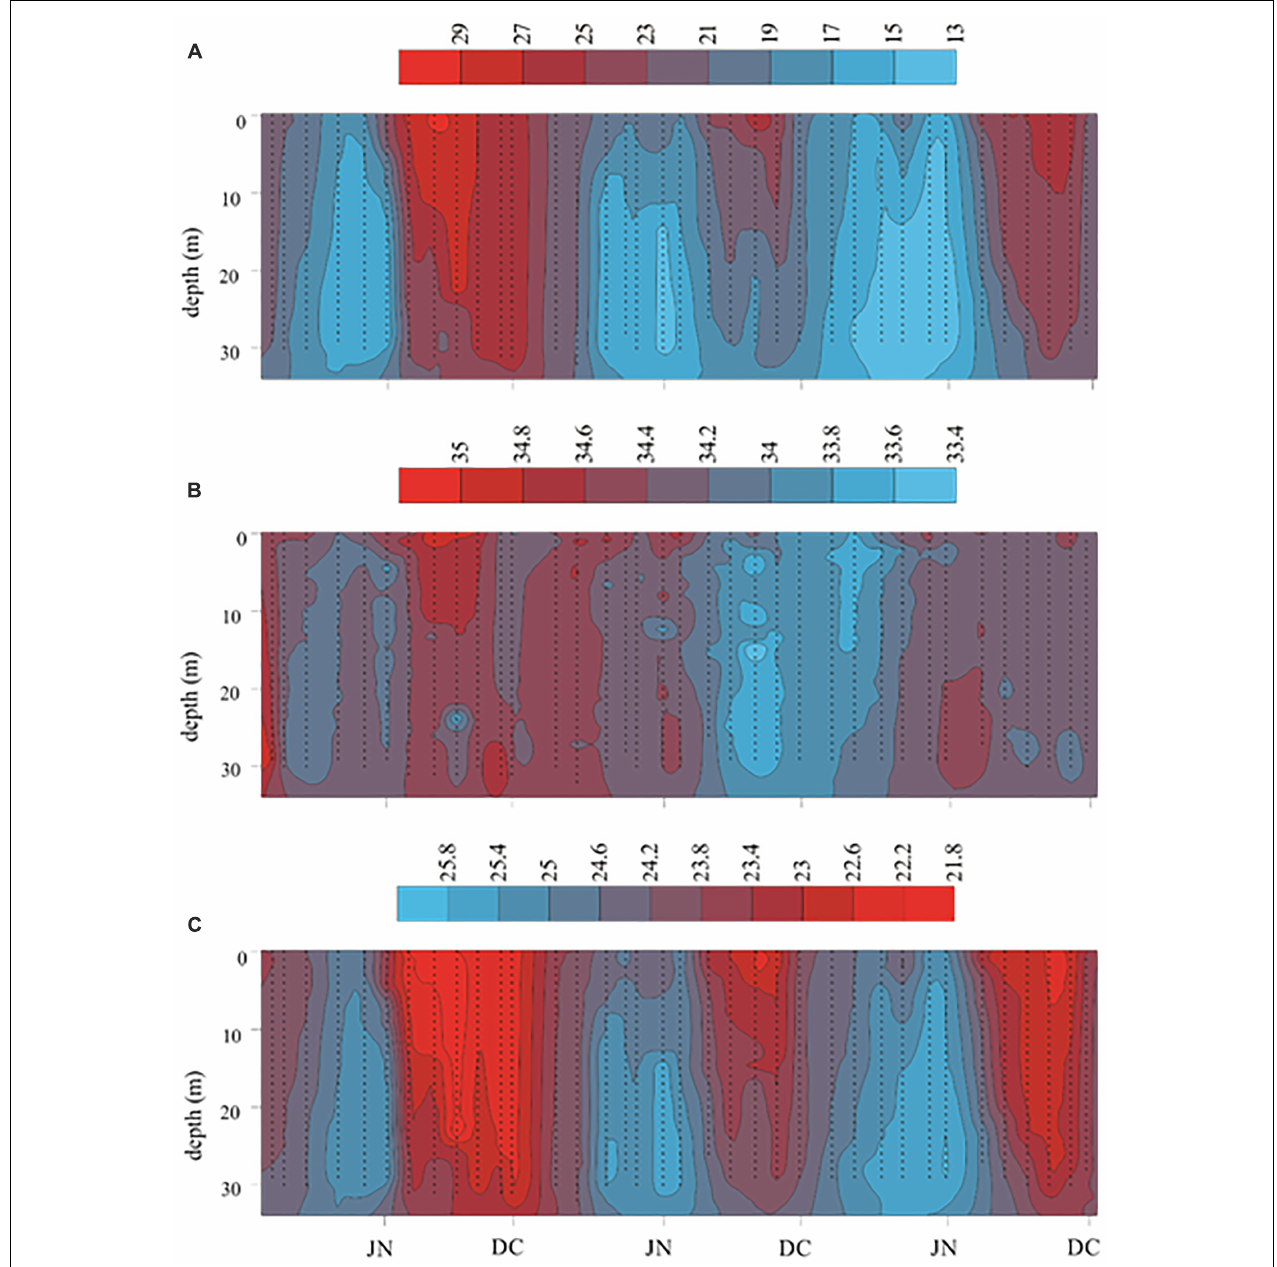
FIGURE 3 | Temperature ( ◦ C), salinity and density (kg m − 3 ) monthly distribution in the mouth of Bahia Magdalena from 2015 to 2017. (A) Temperature; (B) Salinity; (C) Density. JN, June; DC,